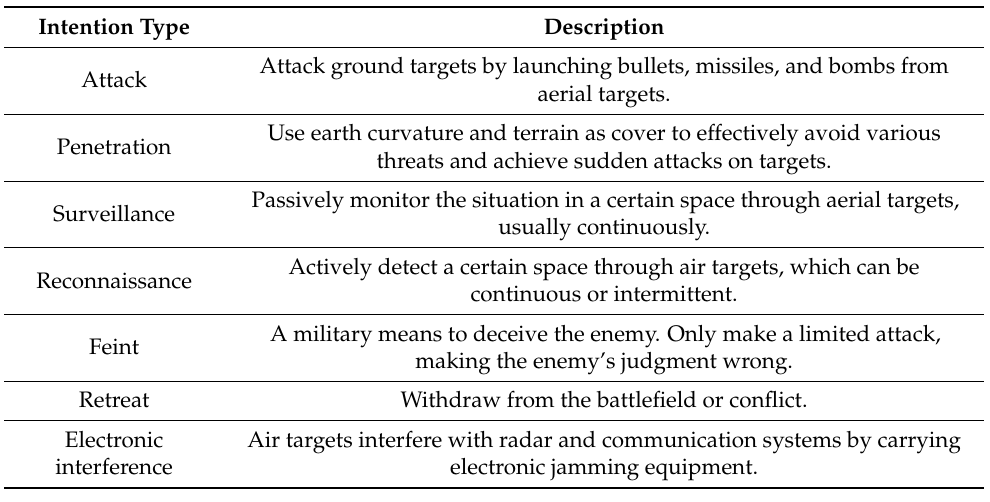
Table A1. Detailed description of seven intention types.